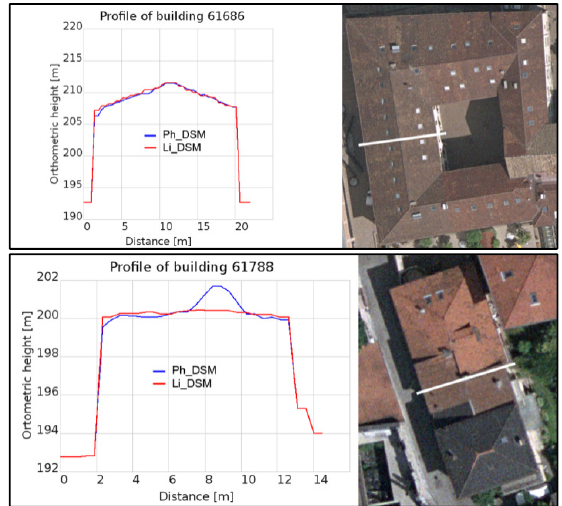
Figure 5: Profiles of two building roofs obtained from the photogrammetric (blue) and the LiDAR DSM (red). In case of flat roof faces [top], both models coincide. In case of irregular surfaces, the higher-resolution photogrammetric DSM can better describe the shape of a chimney.